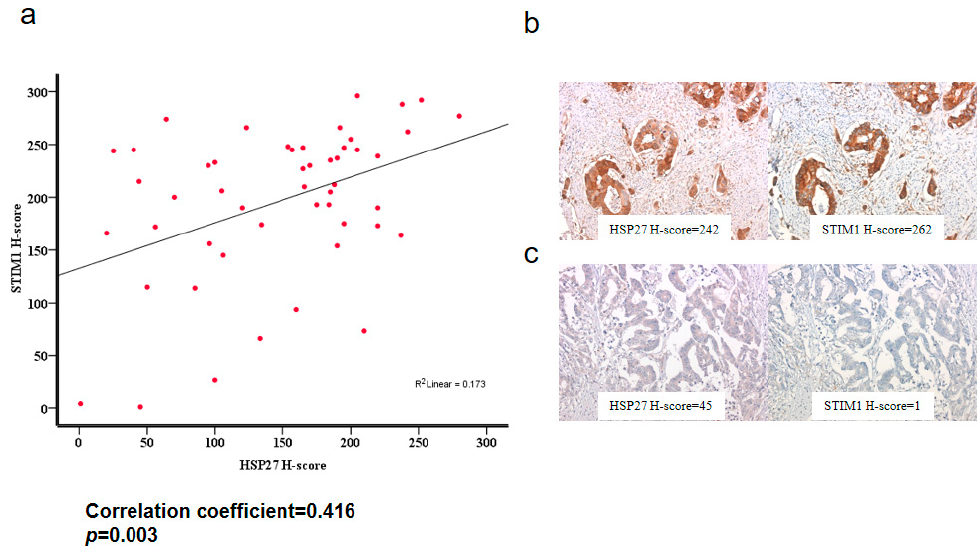
Figure 10. The association between HSP27 and STIM1 expression. ( a ) The scatterplot of H-scores of HSP27 and the corresponding STIM1 expression displayed a positive correlation (correlation coefficient = 0.416, p = 0.003). ( b ) A case of colon adenocarcinoma with a high HSP27 H-score displayed a high STIM1 H-score. ( c ) A case of colon adenocarcinoma with a low HSP27 H-score displayed a low STIM1 H-score.